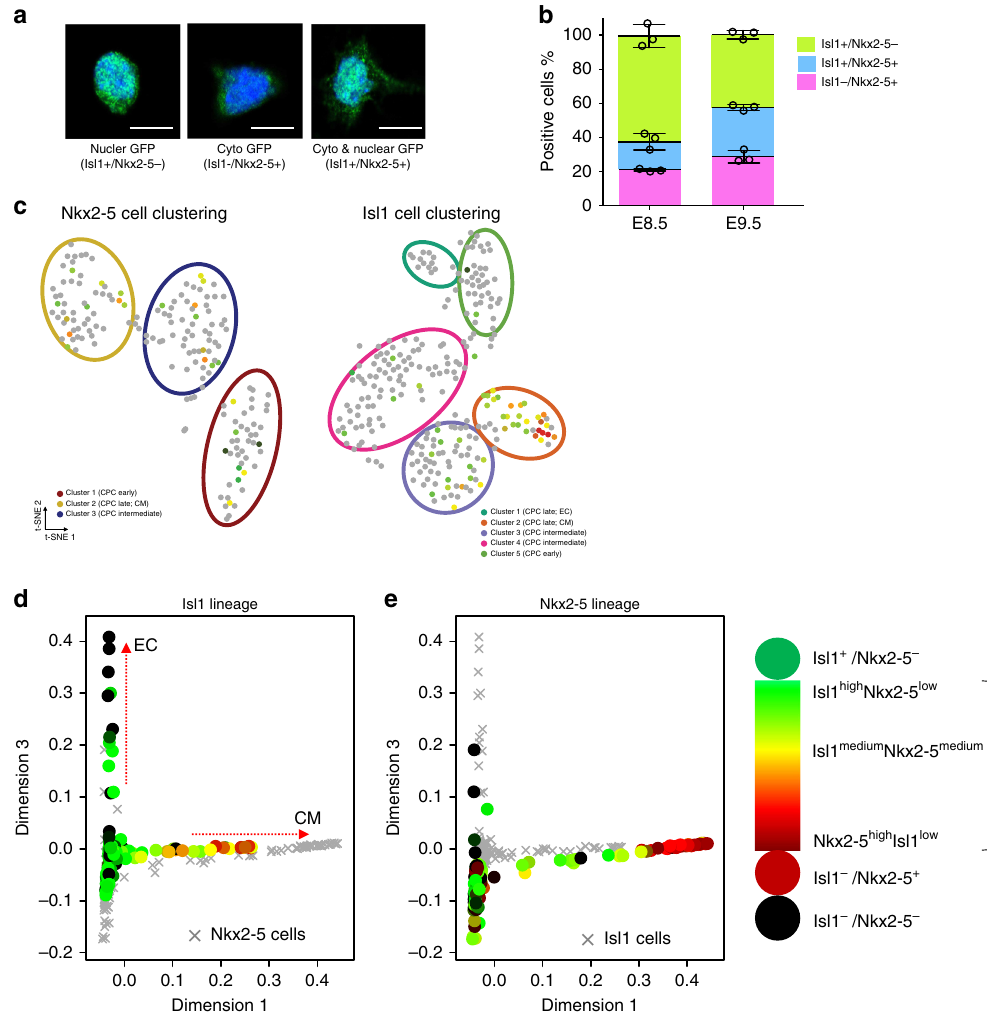
Fig. 3 Comparison of Isl1 + and Nkx2-5 + cardiac progenitor cells. a Confocal images showing nuclear-, cytoplasmic- and co-localization of GFP in CPCs FACS-sorted from Isl1 + /nGFP /Nkx2-5-emGFP + embryos. Nuclei were stained with DAPI (blue). b Immuno fl uorescence-based quanti fi cation of ( a ). Isl1 + Nkx2-5 − , Isl1 + Nkx2-5 + and Isl1 − Nkx2-5 + cells were FACS-sorted from Isl1 + /nGFP /Nkx2-5-emGFP + embryos at E8.5 and E9.5. Quanti fi cation of different cell populations was achieved by counting all immunostained cells in a multiwell dish. Mean ± s.d. are shown. Circles represent results from different biological replicates [ n = 3; Σ (cell number) of E8.5 = 225, 260, 100; Σ (cell number) of E9.5 = 175, 180, 100]. c Clustering of Isl1 and Nkx2-5 co- expressing cells in Nkx2-5 + and Isl1 + CPC subpopulations. Cells that are not double-positive are labeled in gray, and clusters are indicated by colored circles. d , e Plots showing the predicted diffusion pseudotime of Nkx2-5 + cells projected on t-SNE plots of Isl1 + cells, and the expression of Isl1 + ( d ) and Nkx2-5 + ( e ). Expression levels of Isl1 and Nkx2-5 in CPCs are represented by a color spectrum as indicated. EC, endothelial cell. CM,